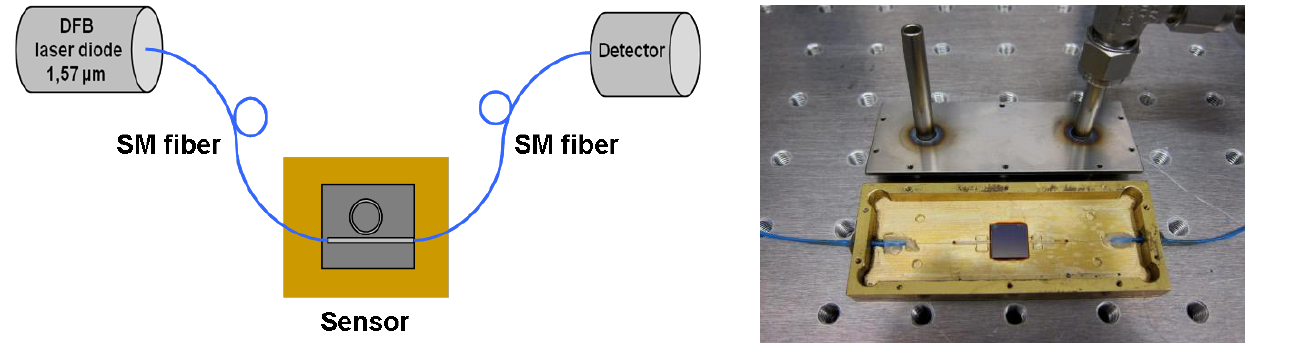
Table 1. Vapour pressure of TNT, 2,4-DNT, 1,3-DNB and H